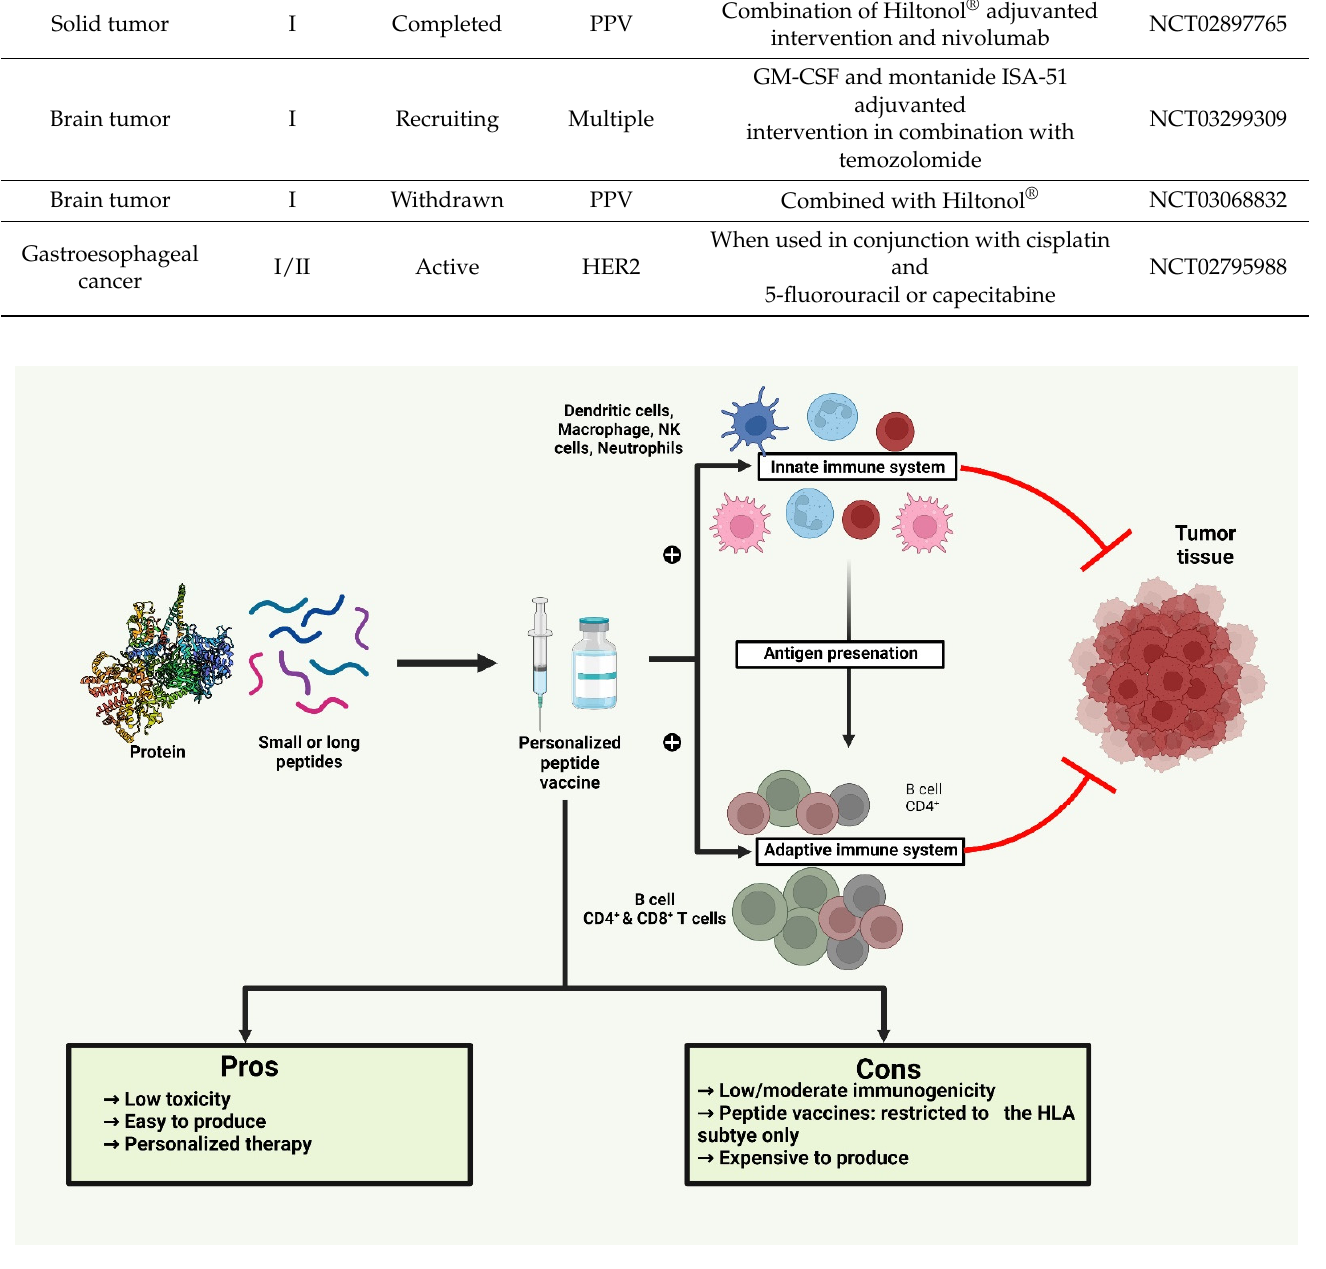
Figure 4 . Representation of activation of CD4 + and CD8 + epitopes through antigen presentation regulated by the innate immune system, which inhibits proliferation of tumor tissue ( Created with biorender . com ).